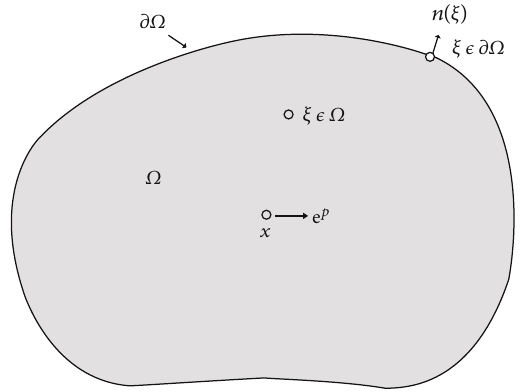
Figure 1: A solution domain with source point x and target point ξ .